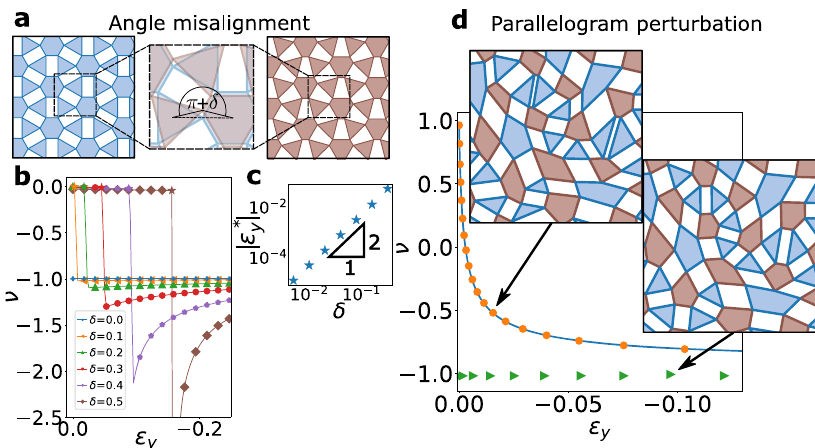
Fig. 3 Breaking the rules. Two interesting examples that break the rules to build a perfect auxetic. a Misaligning pairs of polygons by an angle δ , leaves them no longer collinear between them and their vertex. Notice that this perturbation turns the previously parallelogram holes into trapezoids. This effectively jams the system, delaying its auxetic response as seen in the Poisson ’ s ratio in b (Supplementary Movie 3). Moreover, in c we see how the transition to the auxetic behaviour happens at a strain ϵ (cid:3) y , which scales as δ 2 . d Perturbating the geometry of a perfect auxetic (green triangles) while preserving the parallelogram property of the holes, results in the preservation of the non-trivial fl oppy mode in the system, while changing it ’ s Poisson ’ s ratio (orange circles). The Poisson ’ s ratio of the perturbed system fi ts well with that of a rectangular auxetic (blue line) 23,37 , see Supplementary Note 7 and Supplementary Movie 4. For more information about the measurements, see Supplementary Note